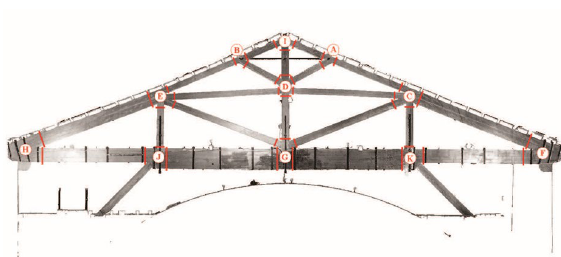
Figure 4: Clipped truss from St. Peter’s point cloud. Extracted cross sections are highlighted in red.